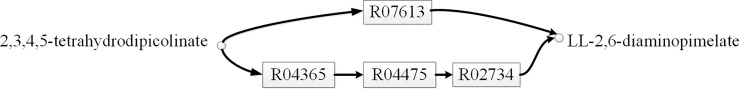
A part of lysine biosynthesis pathway.The square rectangles represent reactions. The compounds are depicted by small circles. Reactions are represented by their KEGG identifiers. Plants use the upper path with a reaction, whereas H. sapiens (human) accomplishes this transformation through the lower path with three reactions.